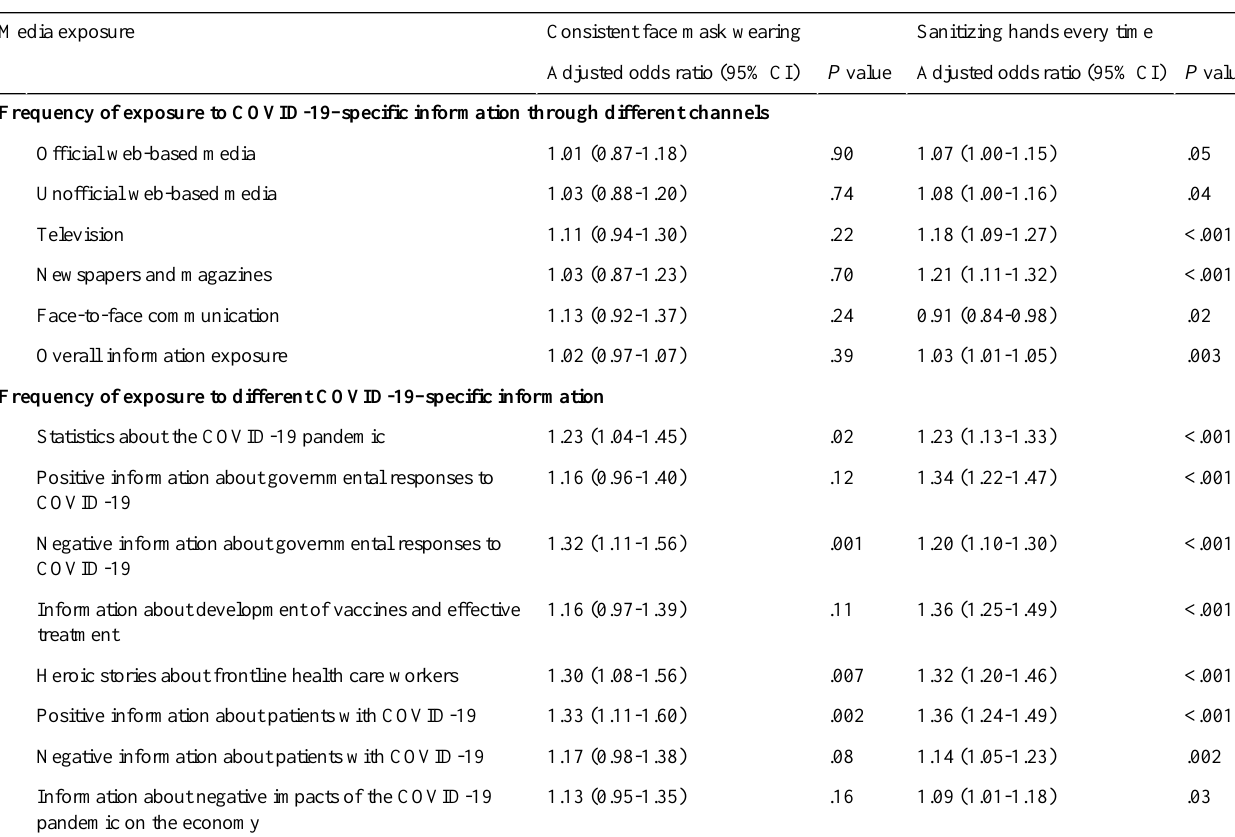
Table 5. Logistic regression of media exposure to COVID-19–specific information and behavioral outcomes (N=3035).